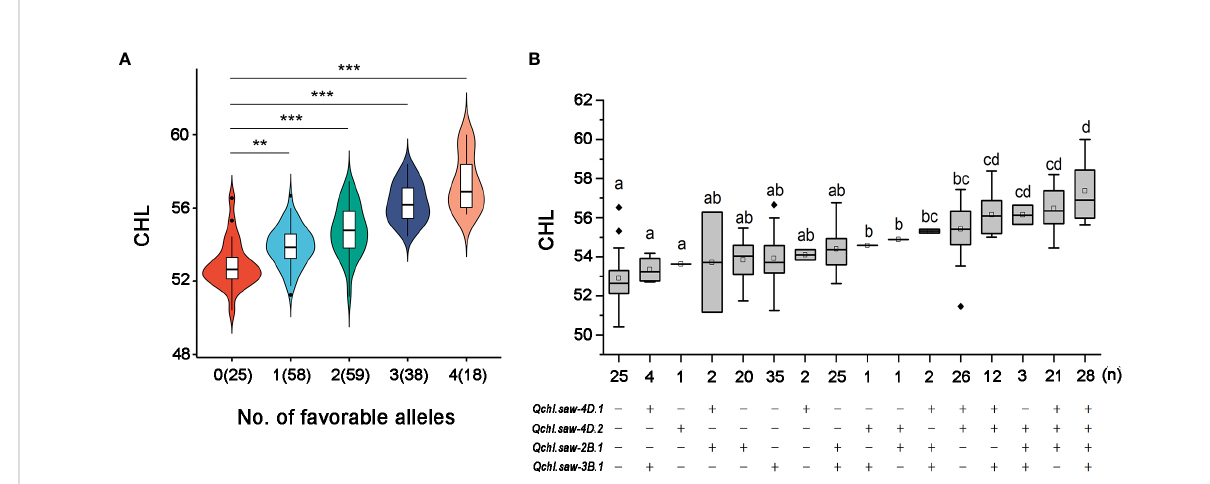
FIGURE 3 Relationship of numbers of favorable alleles and chlorophyll content in the DH1 population (A) . Linear regressions between phenotypes and additive effects of the major QTLs for chlorophyll content in the DH1 population (B) . ** and *** represent signi fi cance at P < 0.01 and P < 0.001, respectively. The letter above the bars indicated comparisons result at the signi fi cant level of 0.05 and